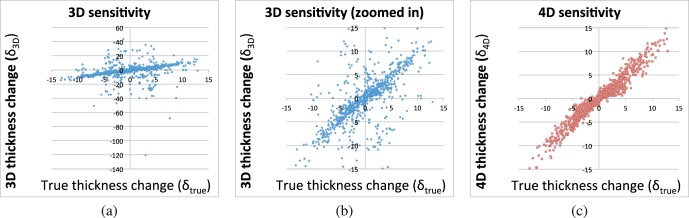
Sensitivity to temporal changes in choroidal thickness. All units are micrometers. (a) Changes in choroid thickness measurements for cross-sectional (3D) segmentation compared with the known synthetic deformation amount. The same data is presented in b after thresholding and zooming to the [−15,15]-μm range, for a fair comparison with 4D. (c) Changes in choroid thickness measurements for longitudinal (4D) segmentation compared with the known synthetic deformation amount. The Pearson correlation coefficients were R2 = 0.299 for 3D and R2 = 0.970 for 4D.